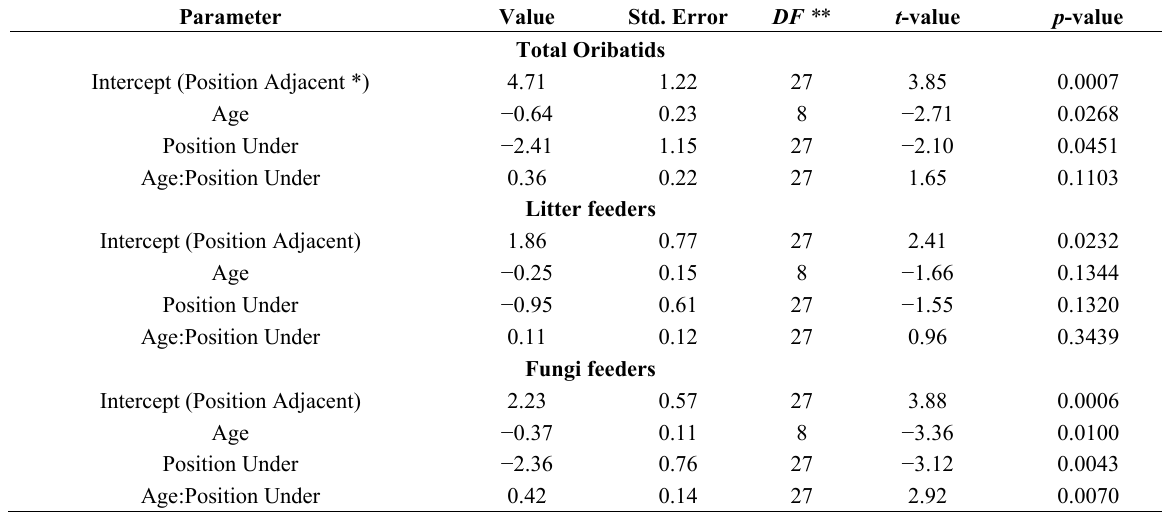
Table 2. Coefficients of the linear mixed effect model fit by restricted maximum likelihood for adult oribatid densities (log transformed) including age of stand (log transformed), position of sample relative to CWM and the interaction as explanatory variables. Value